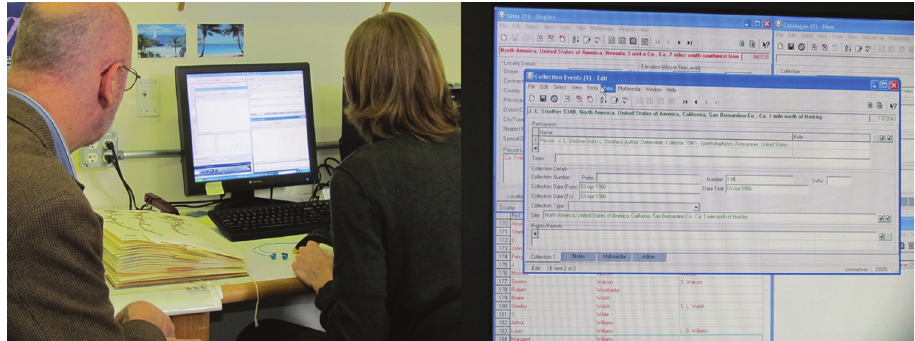
Figure 5. Electronic data capture. Entering data straight from the specimen label into the database. New York Botanical